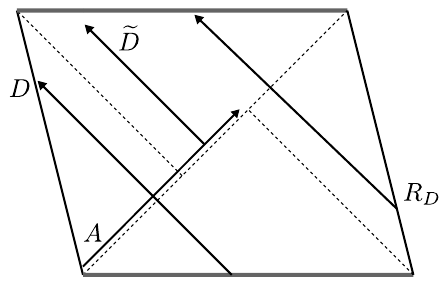
Figure 5 . Bulk interpretation with a